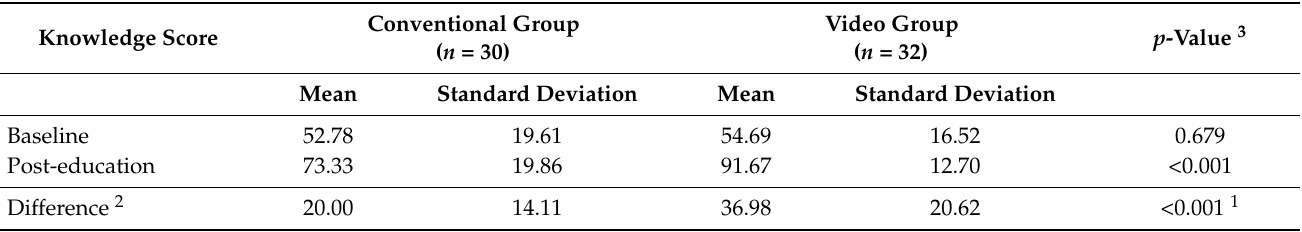
Table 1. Comparison of knowledge scores between conventional and video groups.